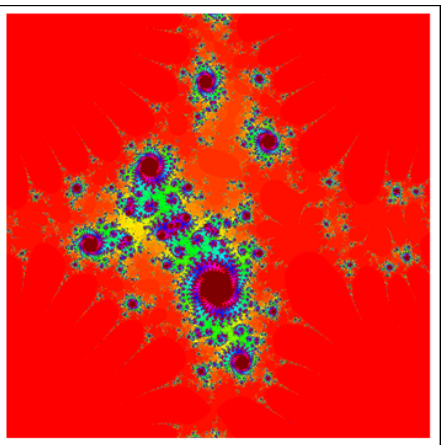
Figure 15. J-set via F-iteration sin ( z 2 ) + ( 0.5 + 0.75 i ) with image visual period = 203.5 s.